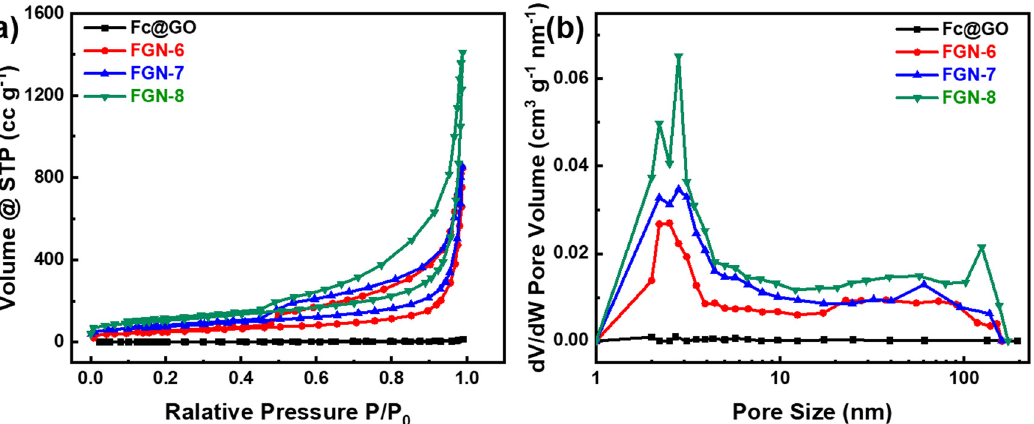
Figure 4: ( a ) N 2 adsorption – desorption isotherms and ( b ) the corresponding pore size distributions of Fc@GO, FGN - 6, FGN - 7 and FGN -